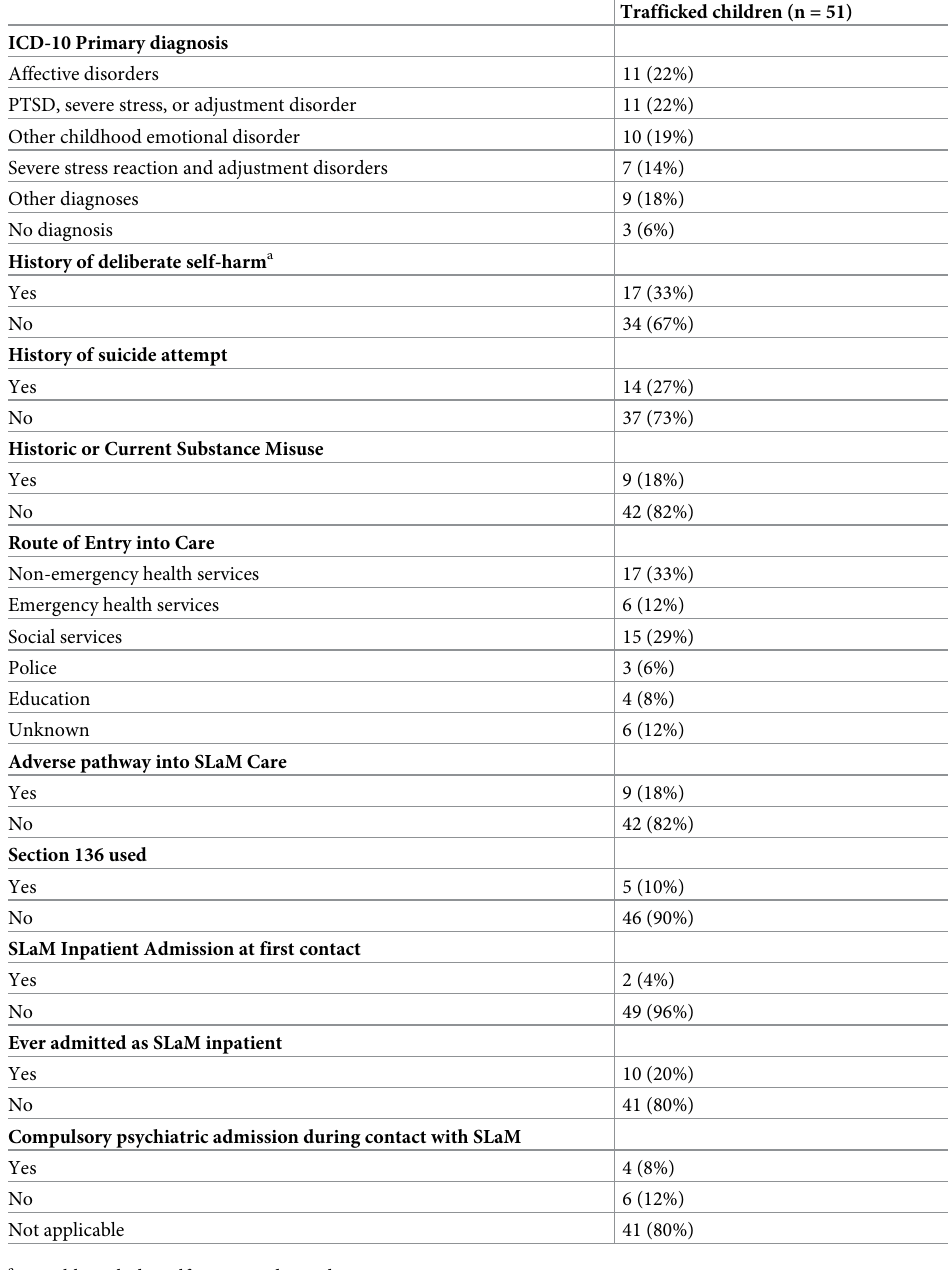
Trafficked children (n = 51)